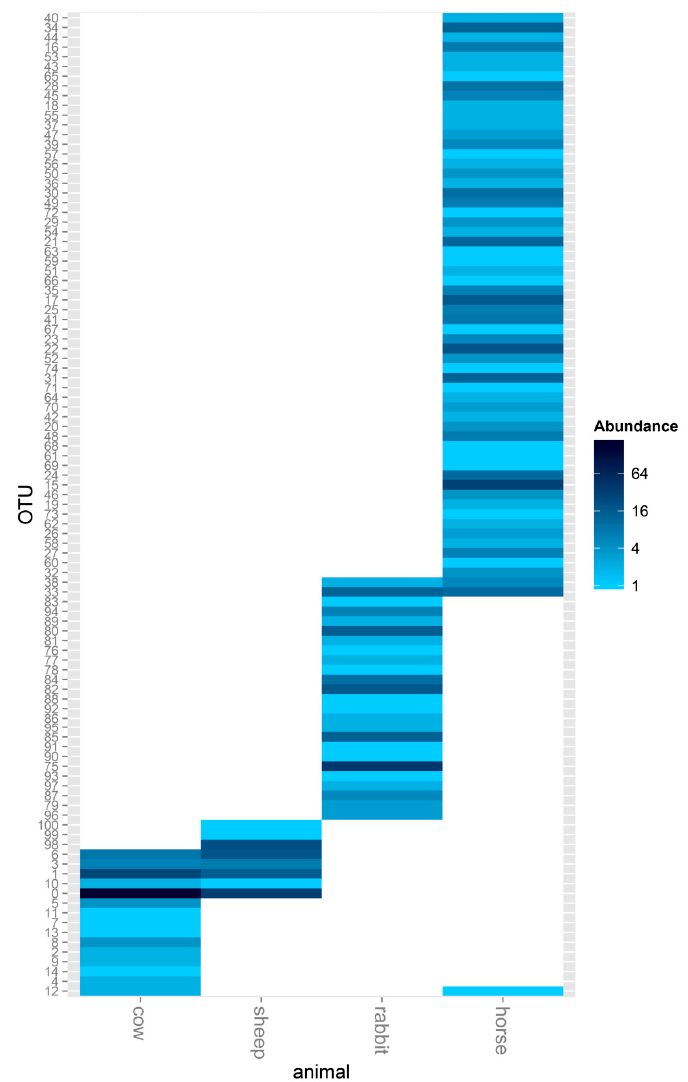
Figure 3. Assessment of differentially expressed ACS genes in the rumens of cows and sheep, the ceca of rabbits, and the feces of horses in a heat map format. A heat map showing all the ACS sequences detected in the rumens of cows and sheep, the ceca of rabbits, and feces of horses. The color scale ranges from blue (high expression) to white (low expression).